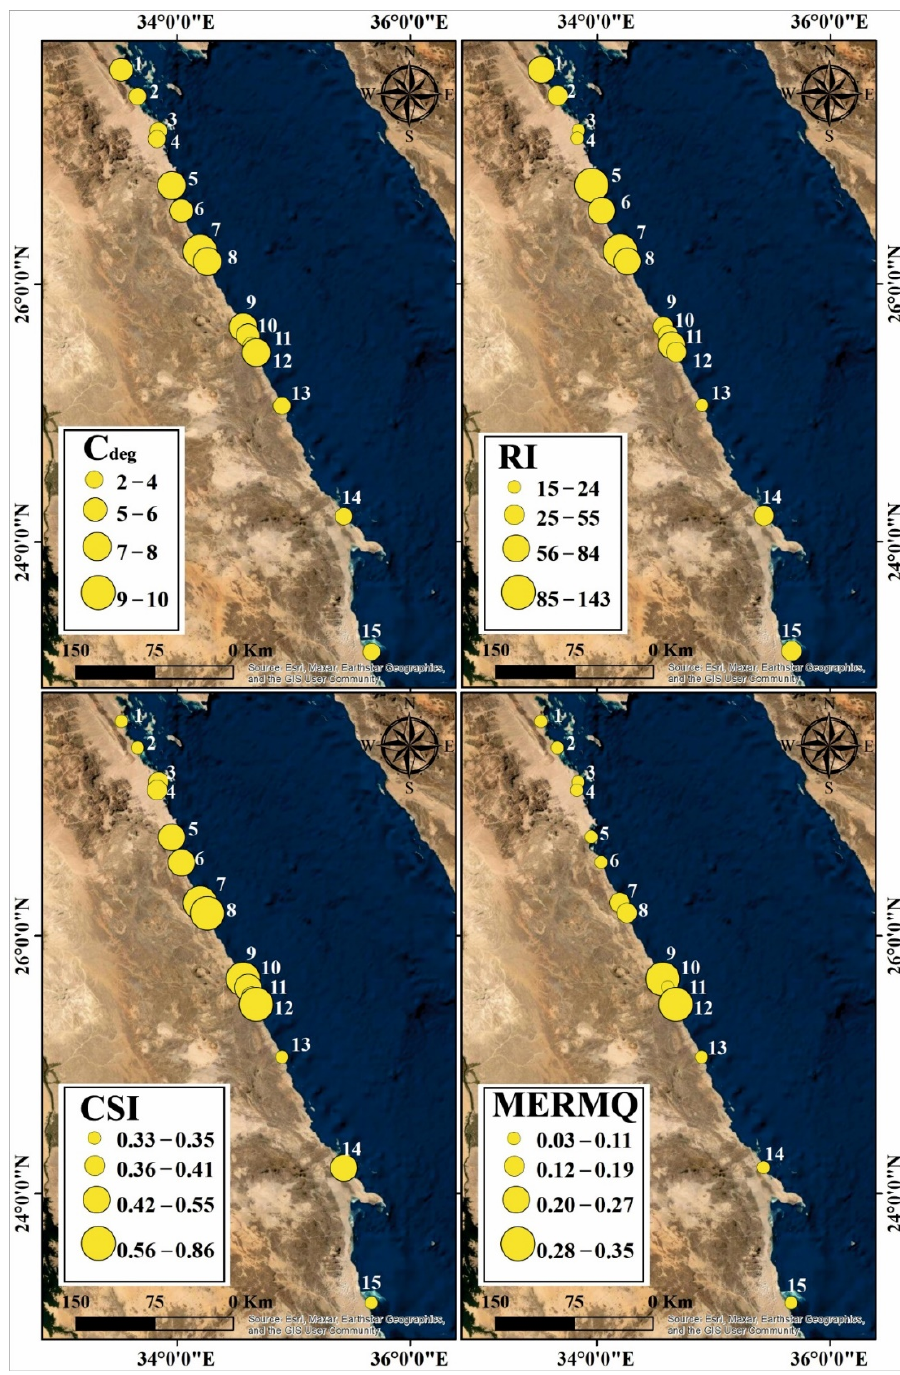
Figure 6. Distribution pattern of C deg , RI, CSI, and MERMQ